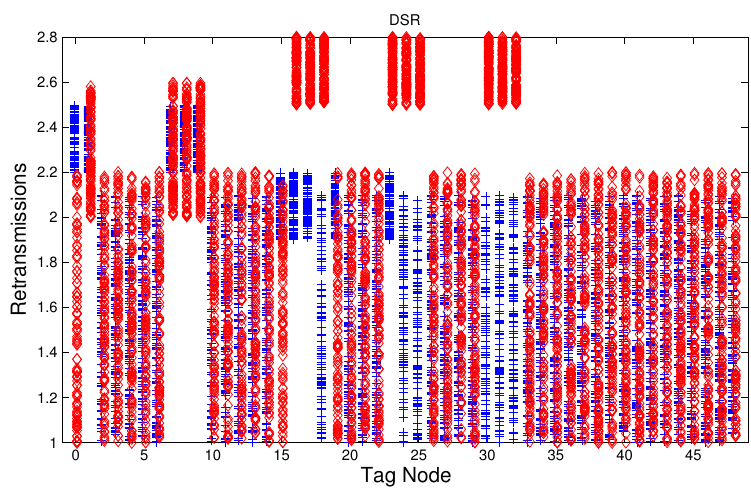
Figure 11. Average number of packet re-transmissions of the nodes from Figure 3 for DSR (Dynamic Source Routing) under normal (blue) and jamming (red) conditions.